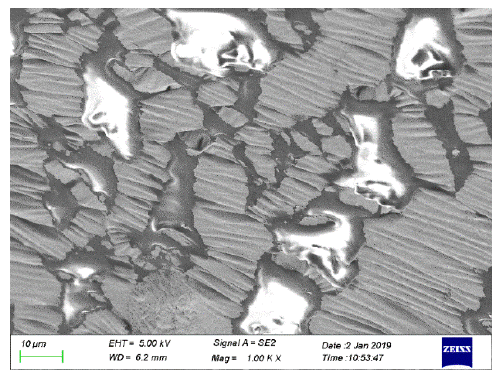
Figure 7. SEM result of nano-CaCO 3 -modified asphalt (magnification: 1000×).